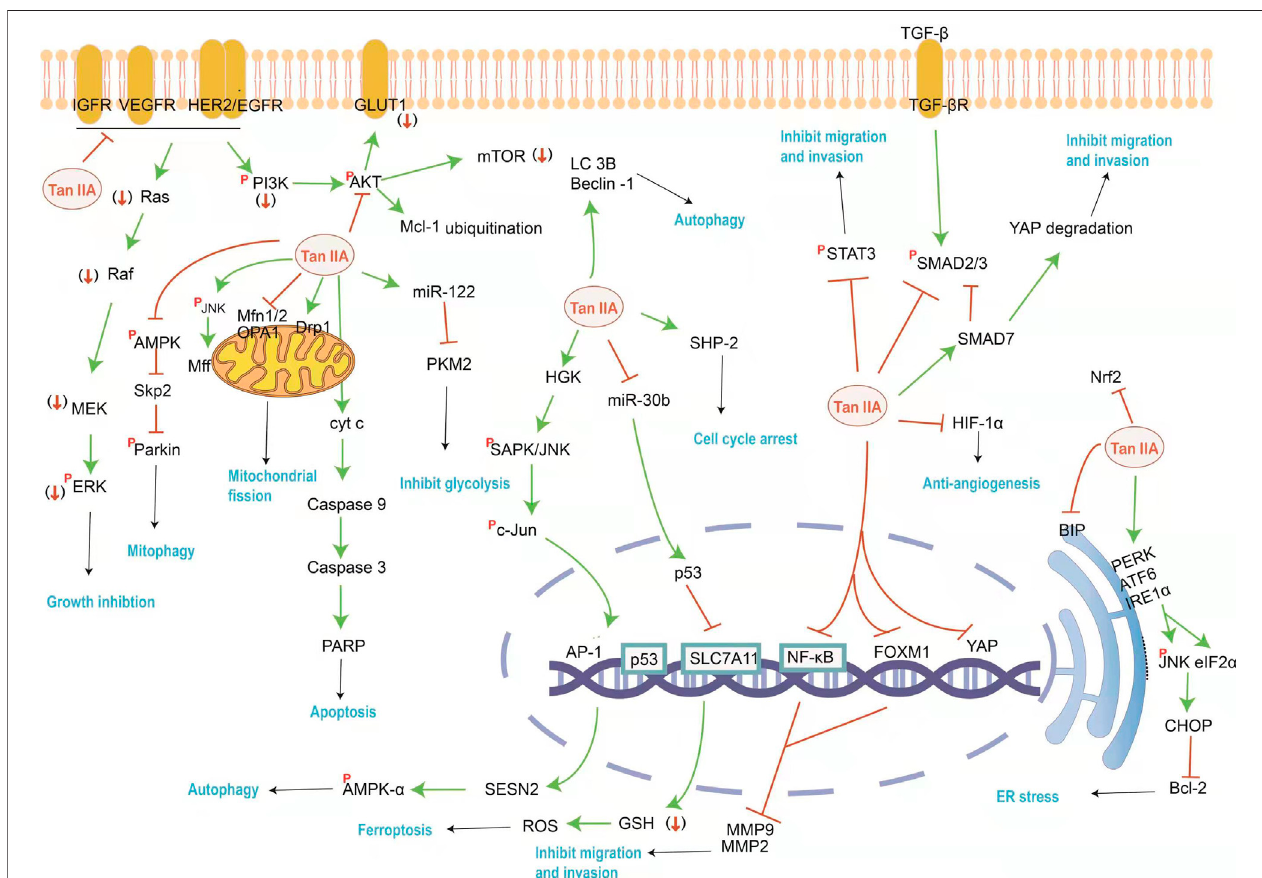
FIGURE1 | The mainly affected targets and pathwaysbyTan IIA against cancer.Tan IIA can inhibit cancercell proliferation and metastasis, induce cell cycle arrest and autophagy, as well as induced ER stress and block energy supply, etc. The orange red symbols ( ↓ ), ┤ and p represent down-regulation, inhibition and phosphorylation of proteins respectively, and green line-arrow “ → ” means singal transduction.